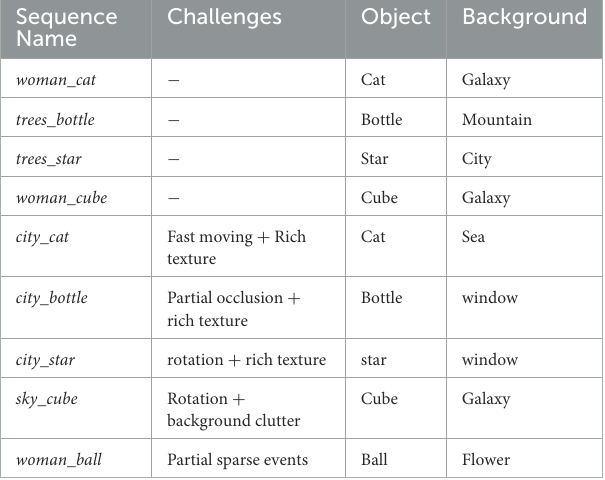
TABLE 1 The details of nine sequences on DVSOT21, where the top four sequences are used for training and the bottom five are used for test. Sequence